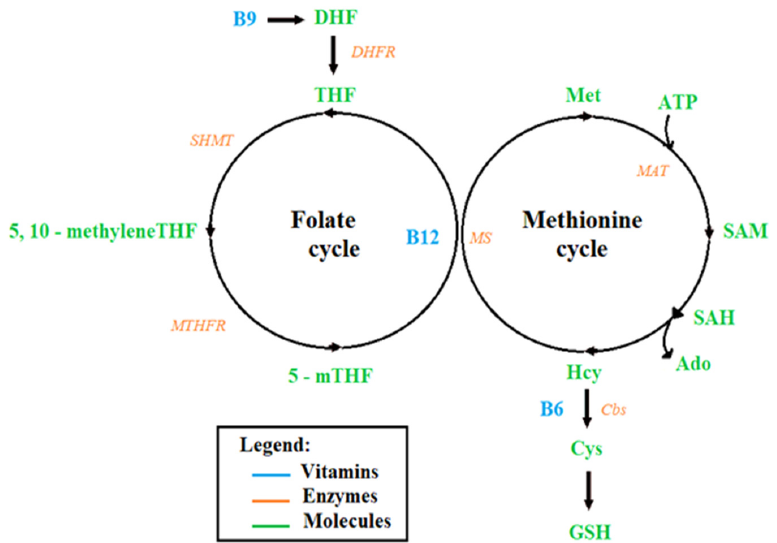
Figure 1. Folate and methionine cycle [16]. Ado adenosine, ATP adeno ‐ sine triphosphate, vitamin B6, vitamin B9, vitamin B12, Cbs cystathionine β synthase, DHF dihydrofolate, DHFR dihydrofolate